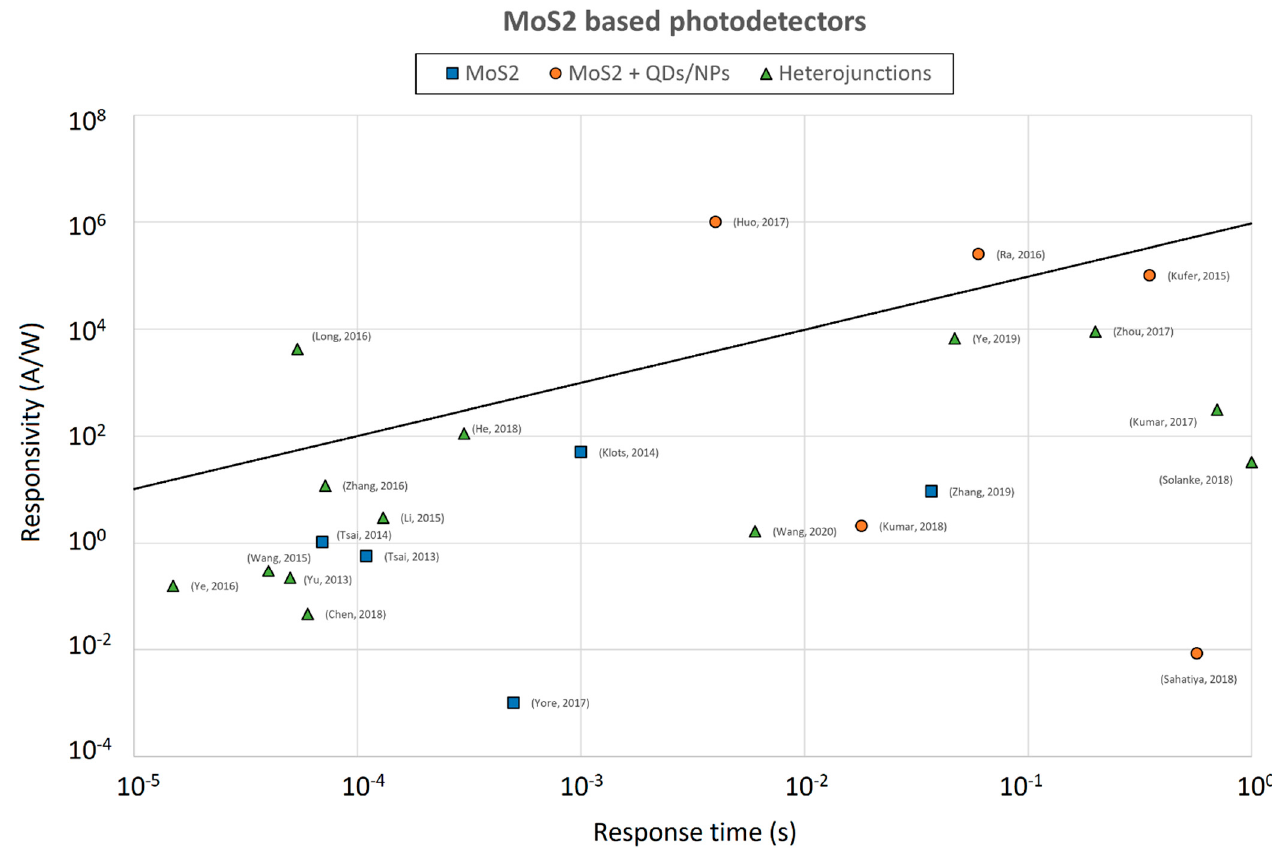
combinations of the electrode materials. Reprinted with permission from ref. [30]. © 2014, AIP Publishing.